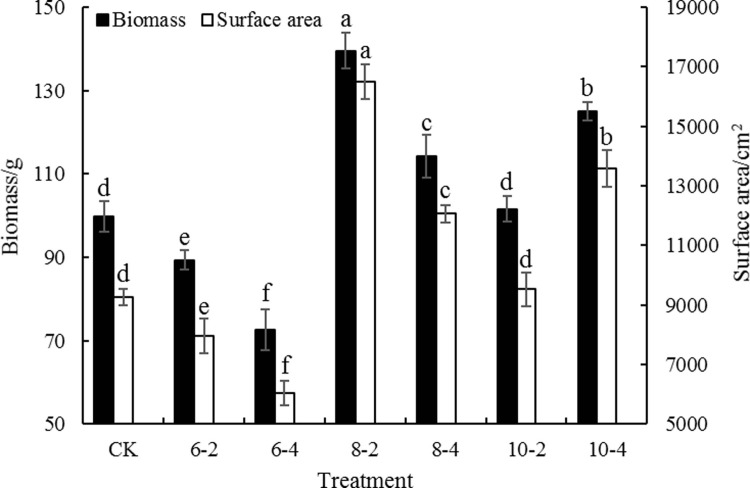
Biomass and surface area of fine root as affected by different pruning treatments.Bars are means and error bars are standard deviations (n = 3). Different letters indicate significant differences among treatments at P<0.05 by LSD.